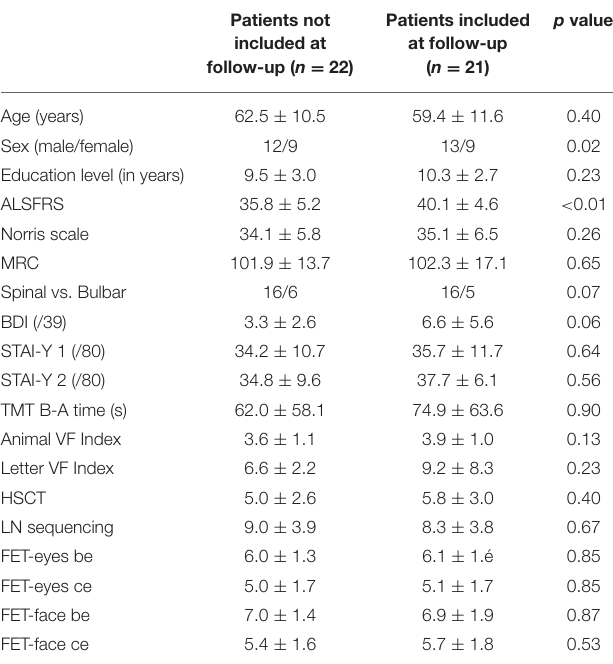
TABLE 1 | Sociodemographic, clinical, psychological and cognitive data of patients and controls at baseline. Patients Controls p -value